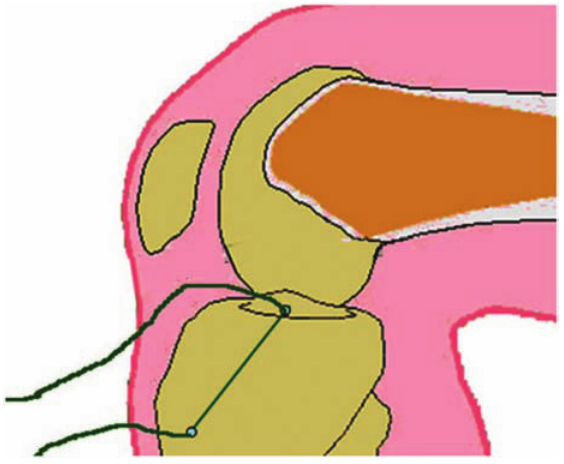
Figure 1 - The suture wire was pulled through the tibia into the knee after drilling with the guide